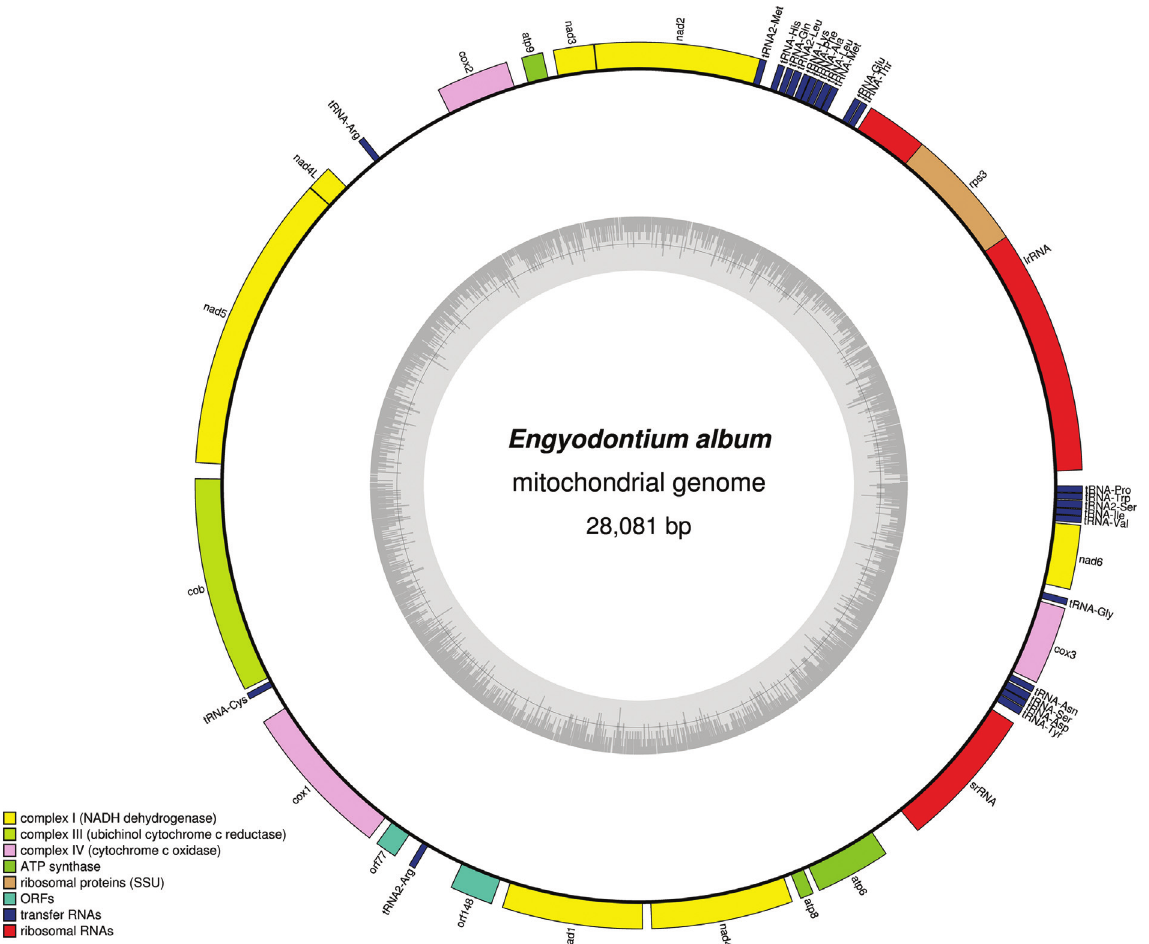
Figure 1 - Mitochondrial genome map of Engyodontium. album . Genes are transcribed in a clockwise